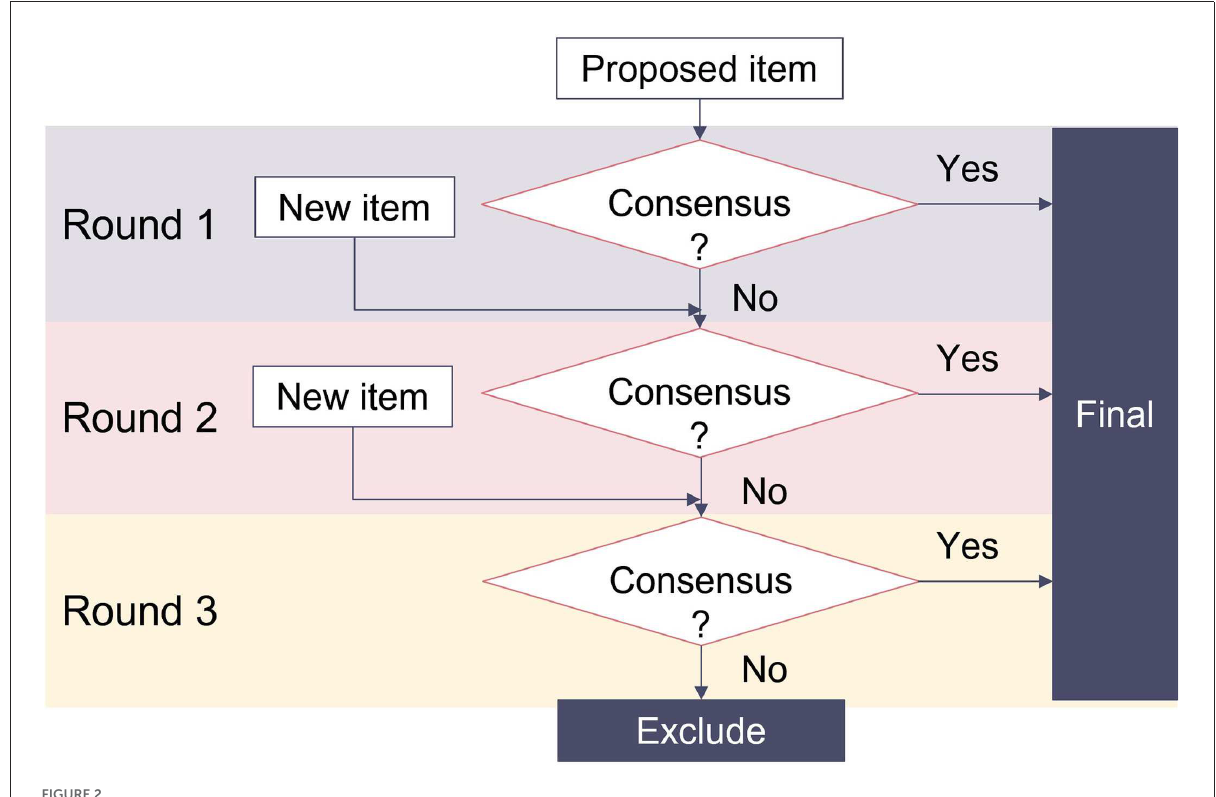
FIGURE2 Item generation process through a three-round Delphi